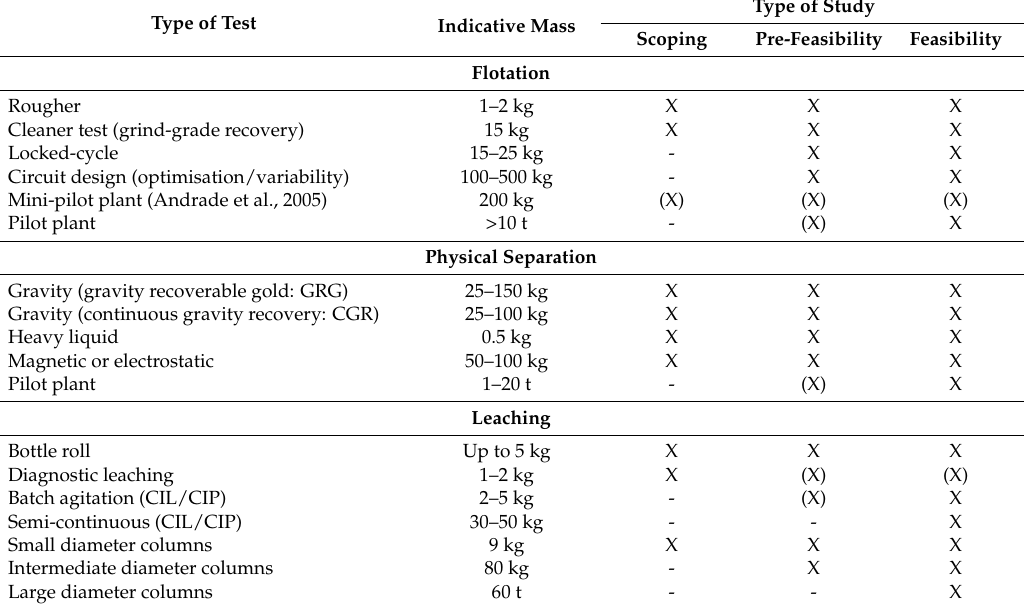
Table 7. Typical metallurgical recovery testwork and test mass required for project studies (modified from [17]). X: expected application; (X): potential